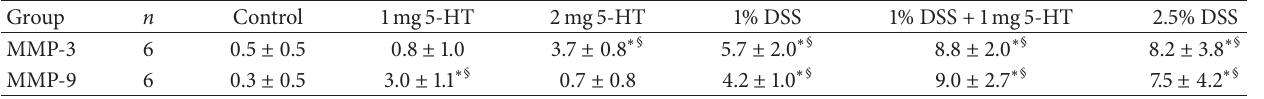
Table 5: Analysis of MMP-3 and MMP-9 protein levels by IHC in mouse colon.